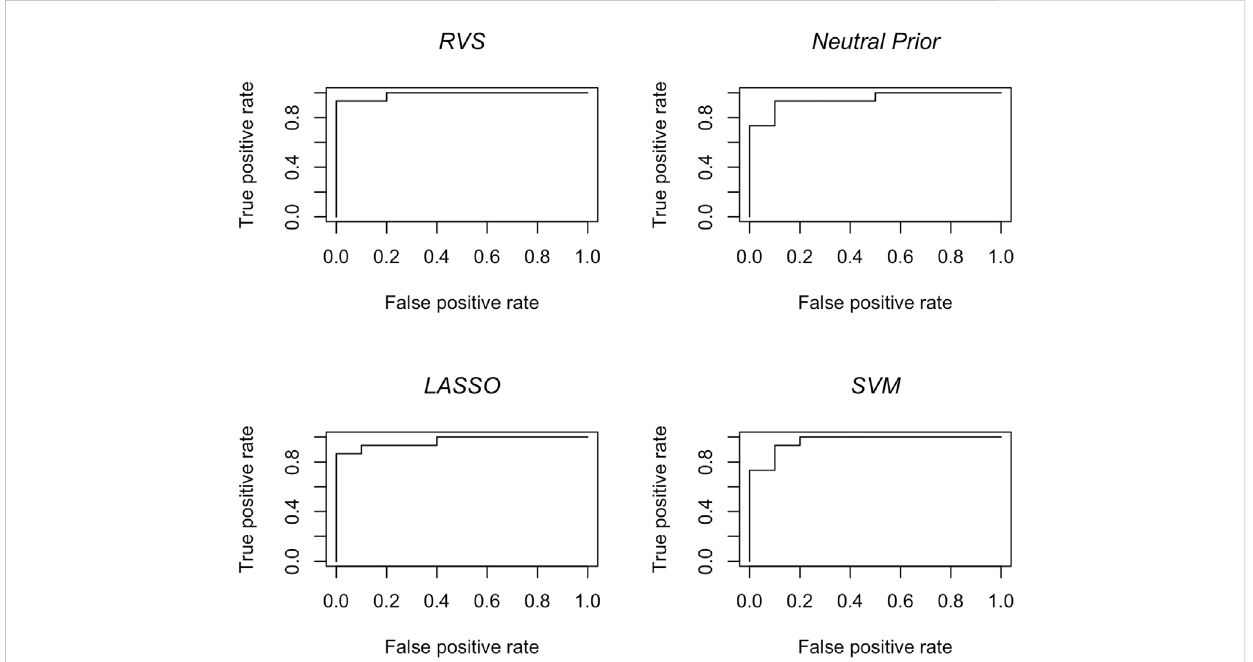
FIGURE 4 Classi fi cation accuracy: ROC curves for the RVS model, the Bayesian model with a neutral prior, lasso logistic regression, and SVM on an example simulated test set, as described in Section